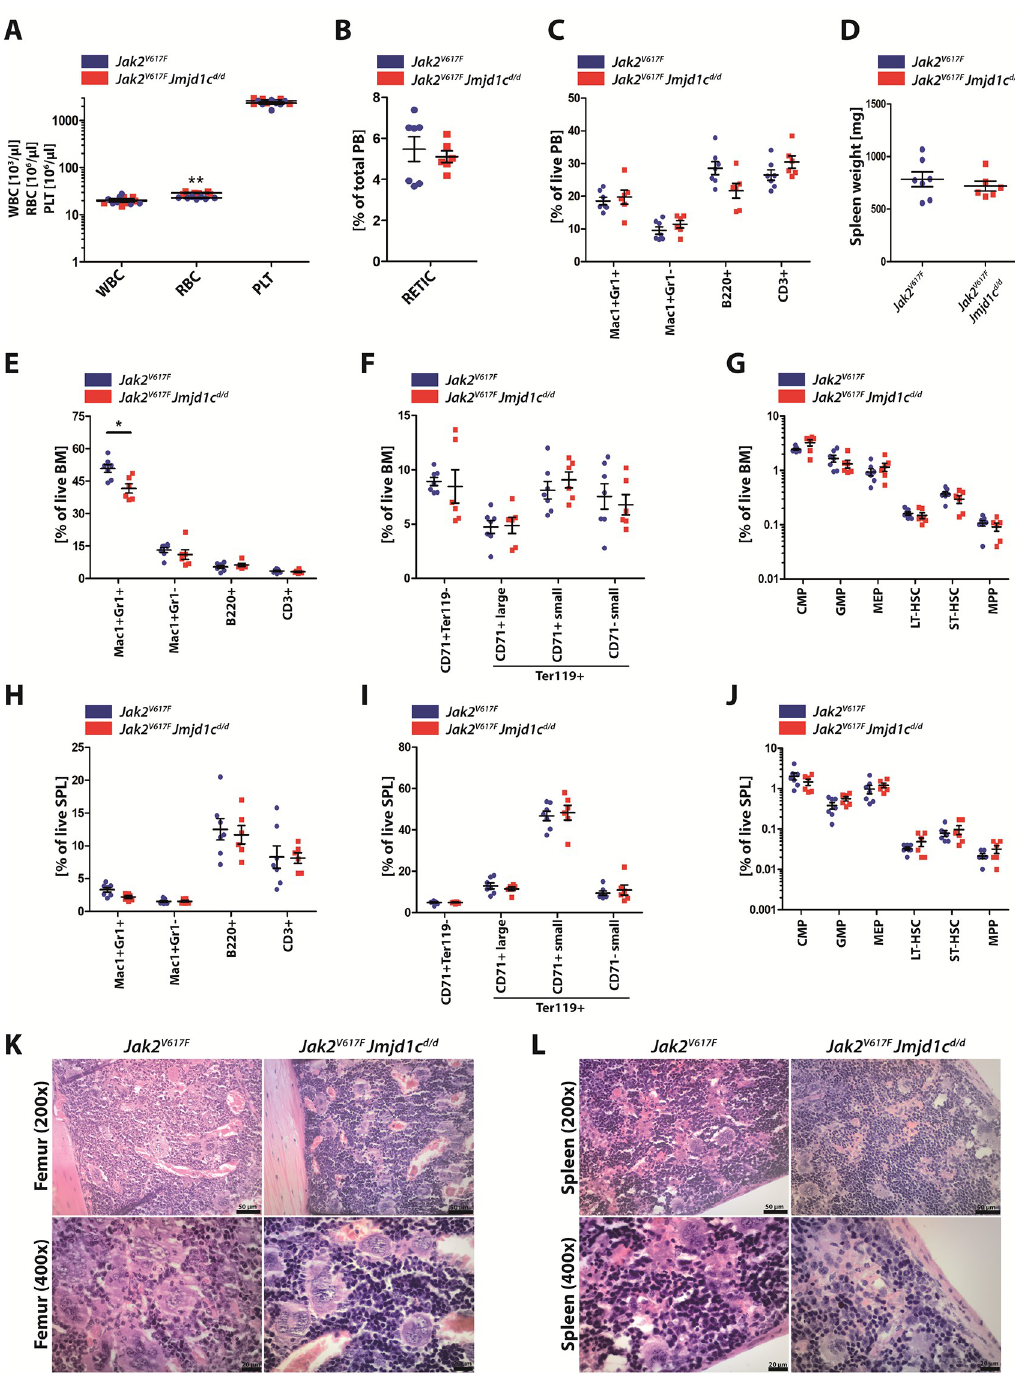
Fig 5. Loss of Jmjd1c is dispensable for Jak2 V617F -driven myeloproliferative disease. (A-L) Analysis of 12-week-old Jak2 V617F and Jak2 V617F Jmjd1c d/d mice (n = 6–7 per genotype, lost data points are shown in S2 Table). (A) PB count. (B) Reticulocytes in PB samples. (C) FACS staining for mature blood cells in PB samples. (D) Spleen weight. (E-G) FACS staining for mature blood cells (E) , erythroid precursors (F) and HSPC (G) in BM samples. (H-J) FACS staining for mature blood cells (H) , erythroid precursors (I) and HSPC (J) in SPL samples. (K and L) Representative H&E staining of formalin-fixed and paraffin-embedded femur (K) and spleen tissue (L) of Jak2 V617F (left) and Jak2 V617F Jmjd1c d/d mice (right). Scale bars: 50 μ m (top) and 20 μ m (bottom). Data are represented as mean +/- SEM in A-J . � P < 0.05, �� P < 0.005. Mann-Whitney U test was used for statistical